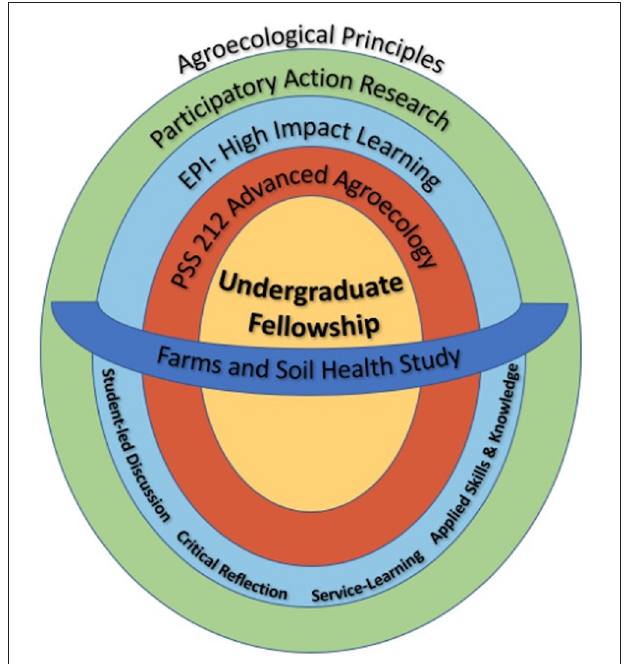
FIGURE 2 | UARFP egg